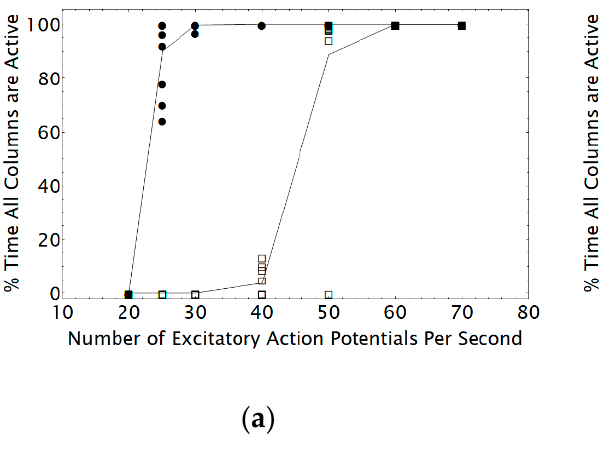
Figure 6. The results reported in Figure 4 for simulations of neurons in 25 columns are shown here for simulations of neurons in 49 columns. Although the general shapes of the average values joined by lines are similar to those found for 25 columns, the onset of continuously active neurons in all columns occurs for lower values of the control parameter. Panel ( a ) depicts data in the absence of simulated stimulation and panel ( b ) shows data in the presence of simulated stimulation of column 1 neurons.